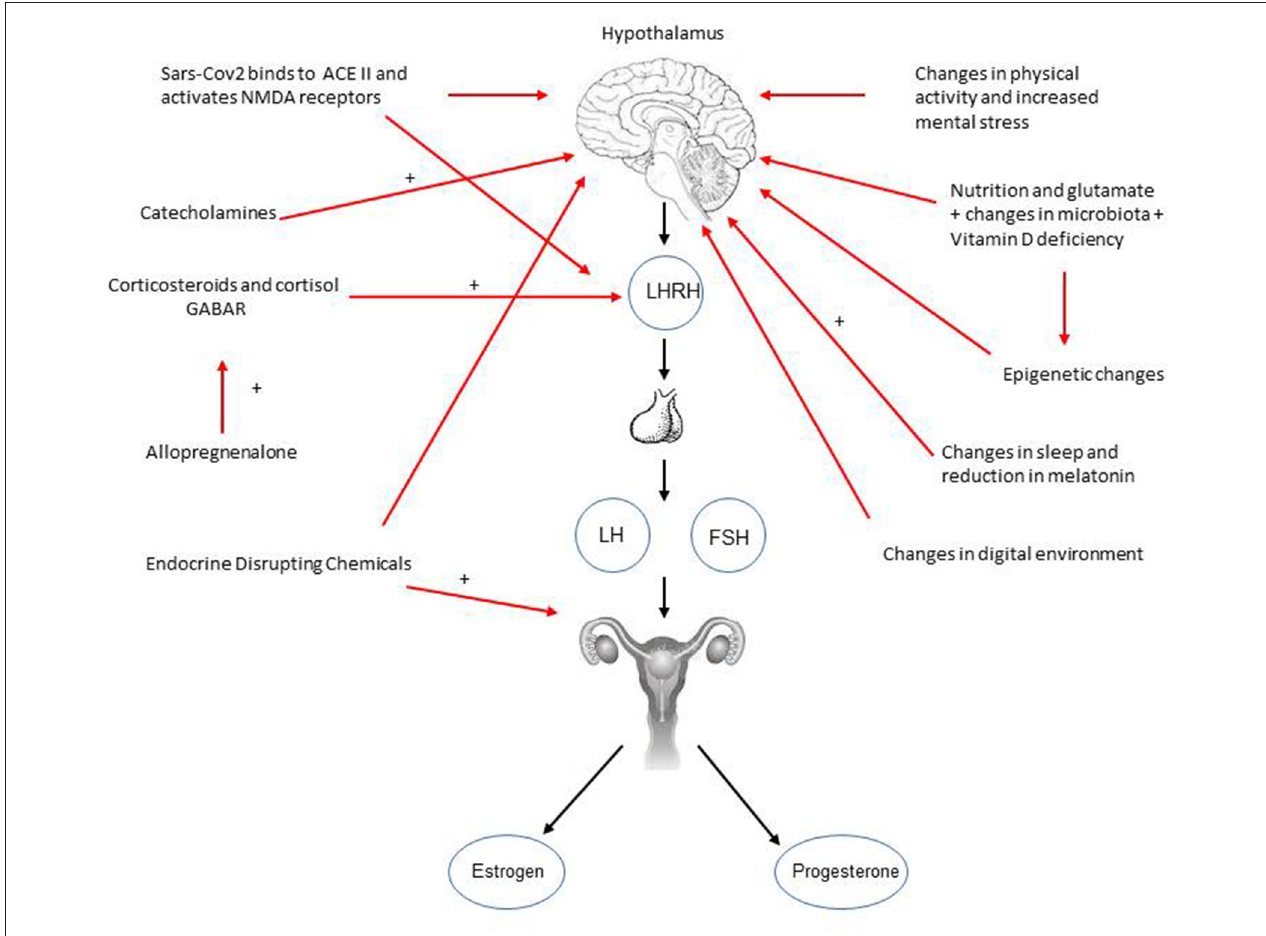
FIGURE 1 | Possible factors contributing/causing precocious puberty and rapidly progressive